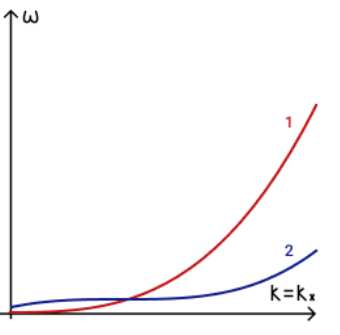
Figure 13. Phase matching condition for three magneto-Rossby waves in low-frequency